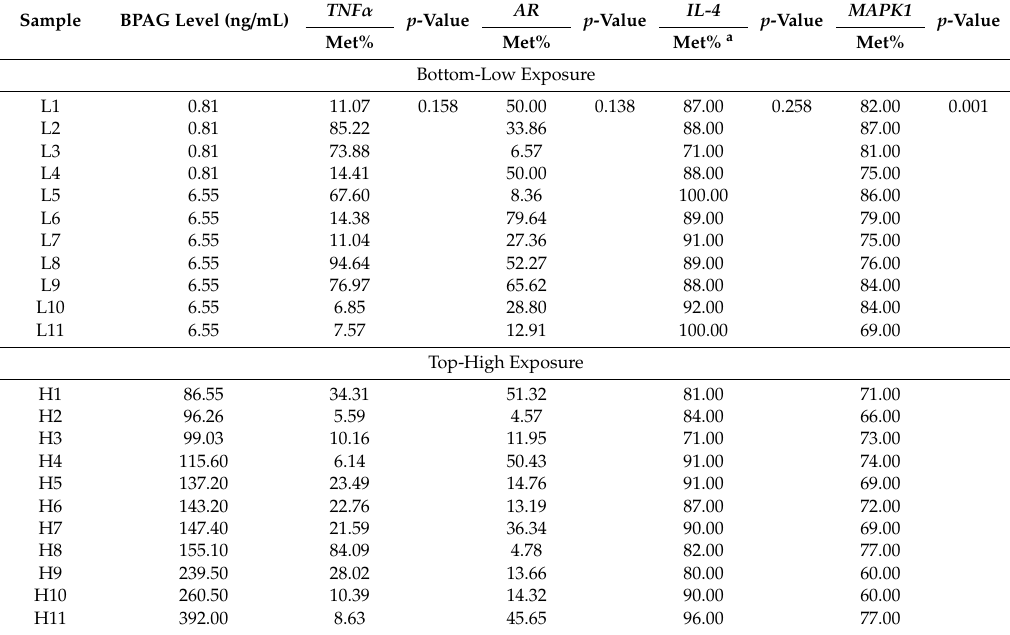
Table 3. Promoter methylation percentage (Met%) of four candidate genes with marginal significant di ff erential methylation validated by quantitative PCR ( N = 22). Sample BPAG Level (ng / mL)